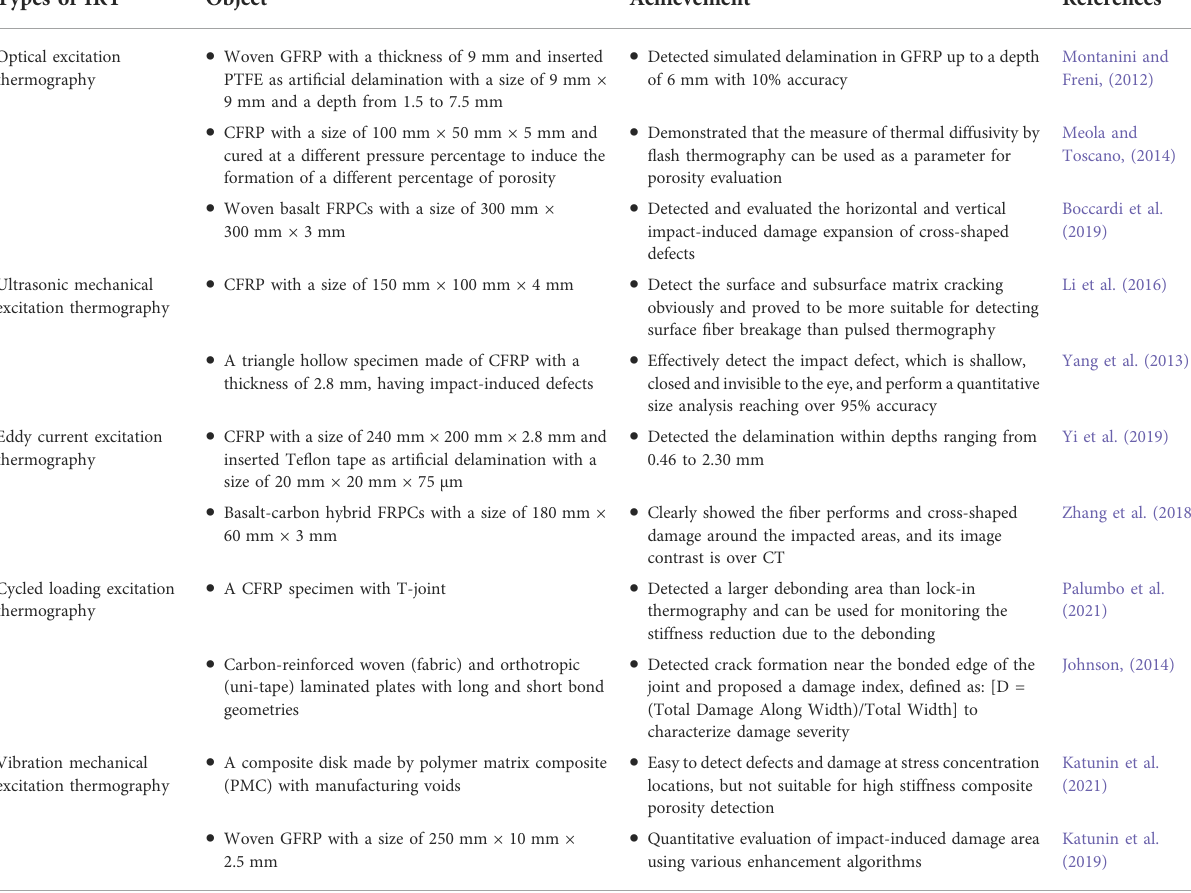
TABLE 2 Summary of typical types of IRT applications for the detection and evaluation of